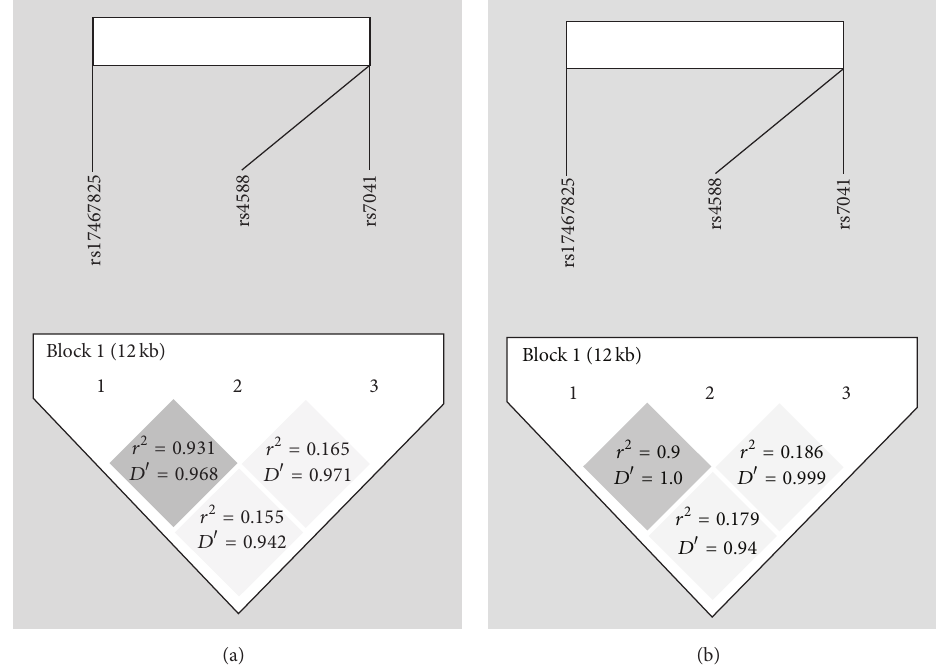
Figure 1: Linkage disequilibrium analysis of DBP SNPs. (a) represents LD analysis in group AgP and (b) represents the result in group HP. The values in the diamonds represent the 𝑟 2 and 𝐷 󸀠 values.